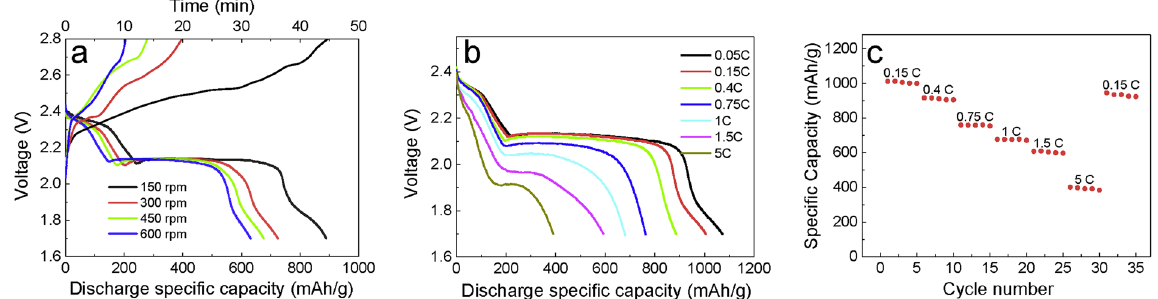
Figure 5. ( a ) Charge profiles of the MWCNTs/S/PPy composites from the TENGs at different rotating rates and discharge profiles at 0.5 C. ( b ) Discharge profiles of the composites charged by the TENGs at 150 rpm at different current rates. ( c ) Rate performance of the composite electrode with current rates ranging from 0.15 C to 5